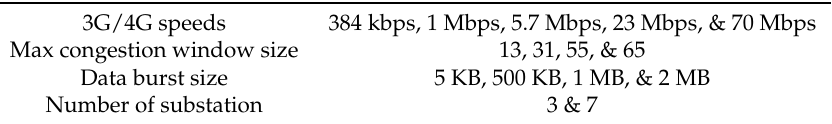
Table 3. Configuration parameters.